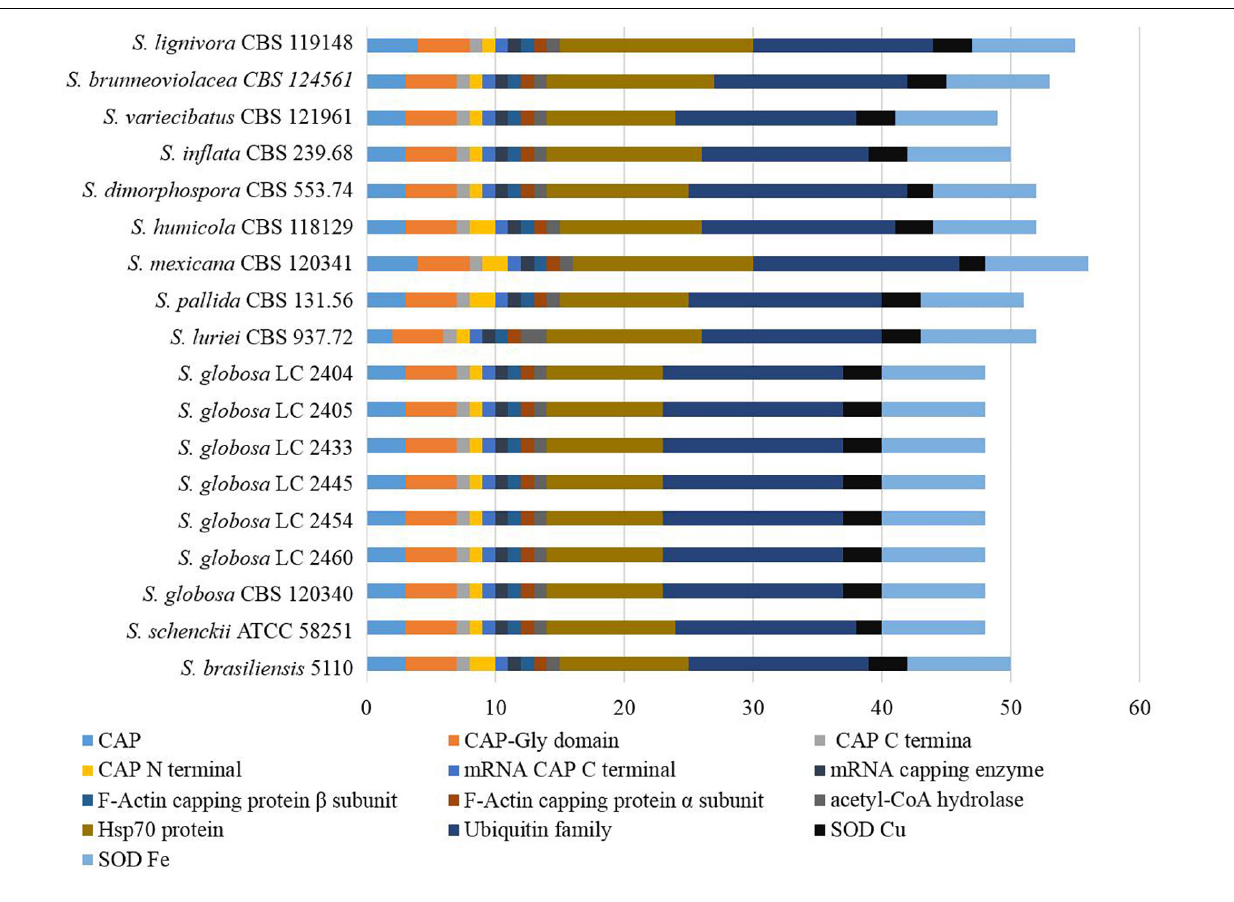
FIGURE 9 | Virulence genes annotated with Pfam in the genus Sporothrix. Virulence gene families assigned by Pfam were summarized into cyclase-associated protein (CAP), Coenzyme A (CoA), heat shock protein 70 (Hsp70), ubiquitin family, and superoxide dismutases (SOD). Significant difference in the five classifications of virulence genes was not observed in different Sporothrix